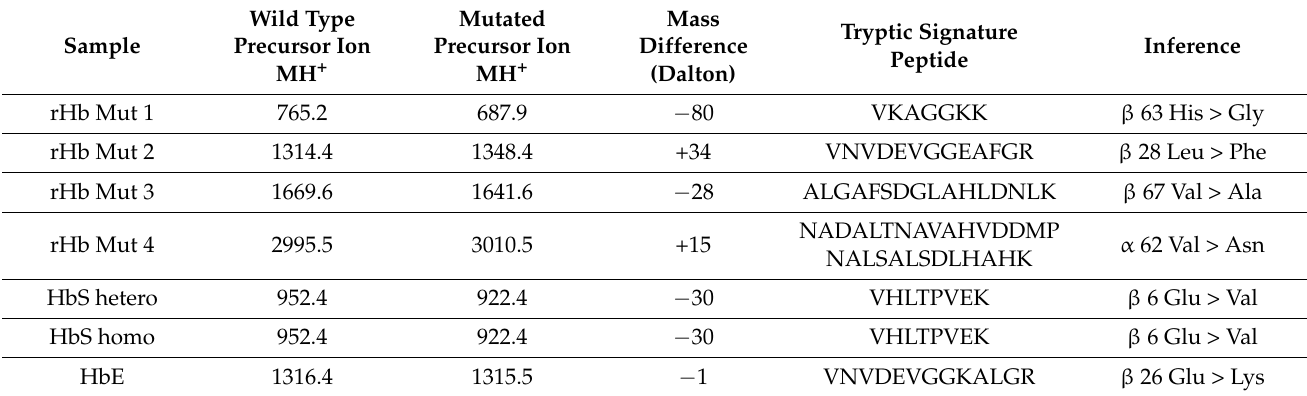
Table 5. Summarized mass spectrometric data for rHb mutants and Hb